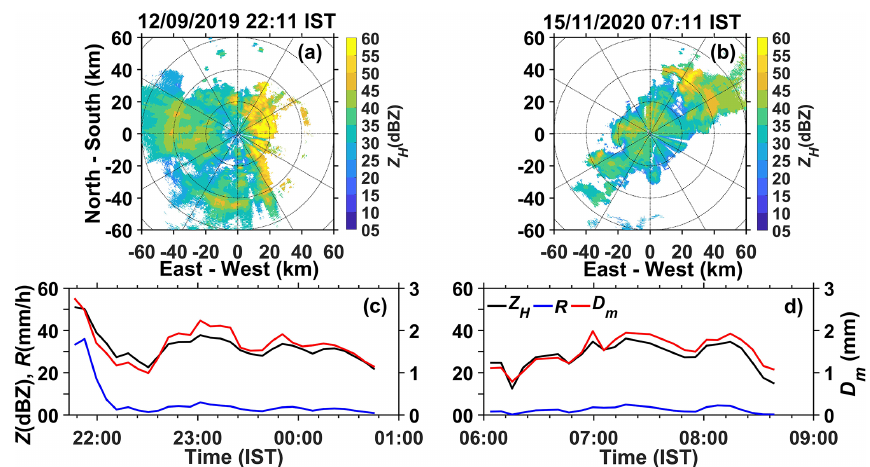
Figure 6. Spatial variation of Z H measured by DROP-X on (a) 12 September 2019 and (b) 15 November 2020. (c, d) Temporal variation of rainfall bulk parameters ( Z H , R and D m ) measured by the disdrometer on the above dates, respectively.